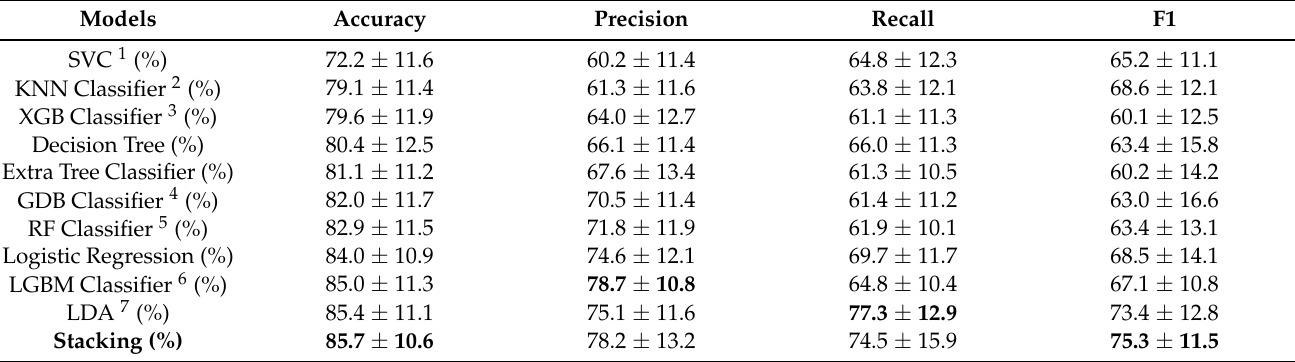
Table 3. Model performance evaluation results.